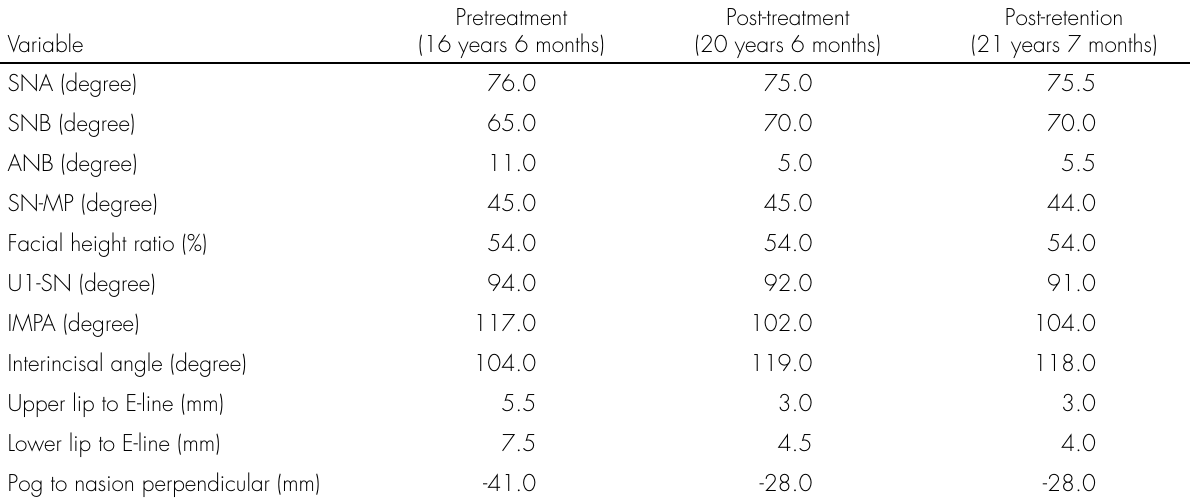
Table I. Comparison of cephalometric measurements from pretreatment through retention.